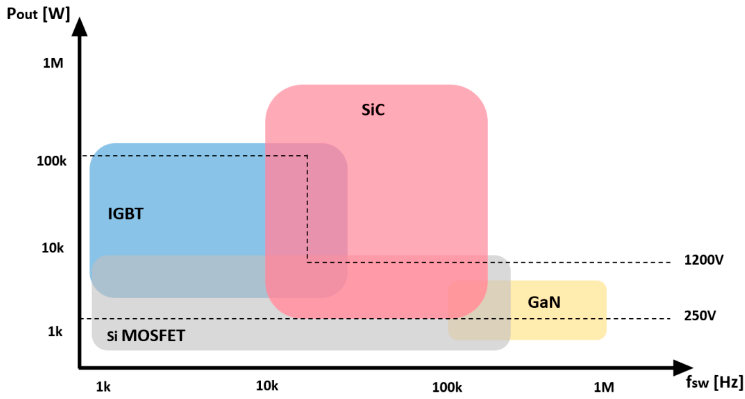
Figure 5. Switching frequency vs. power rating of different semiconductors [63].